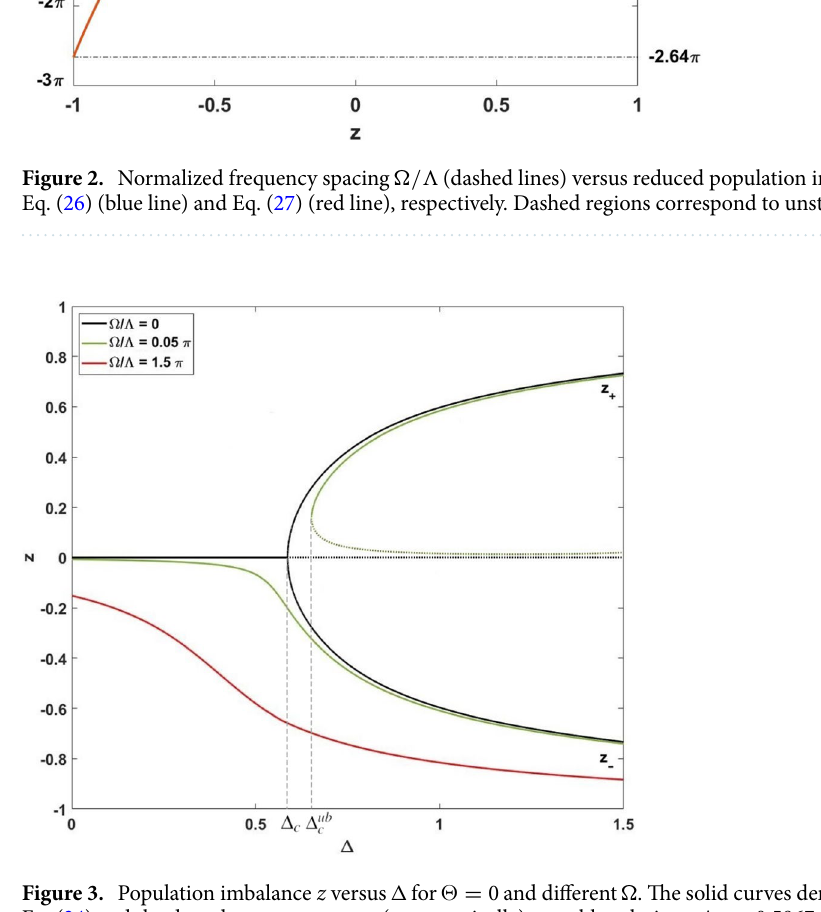
0.5867 and (cid:31) ub 0.647 c = = 0 and =